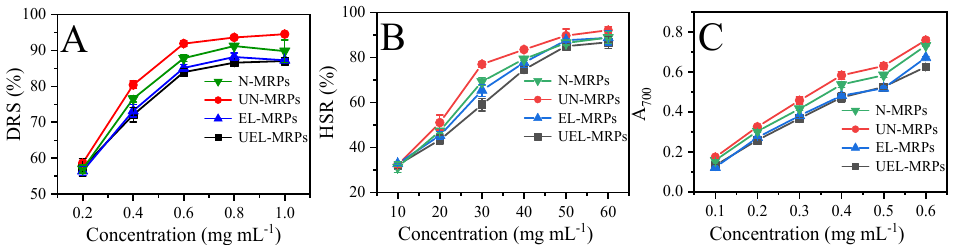
Figure 4. Antioxidant activity of various MRPs. ( A ) DPPH free radical scavenging activity. ( B ) Hydroxyl radical scavenging ability. ( C ) Reducing power, expressed in absorbance read at 700